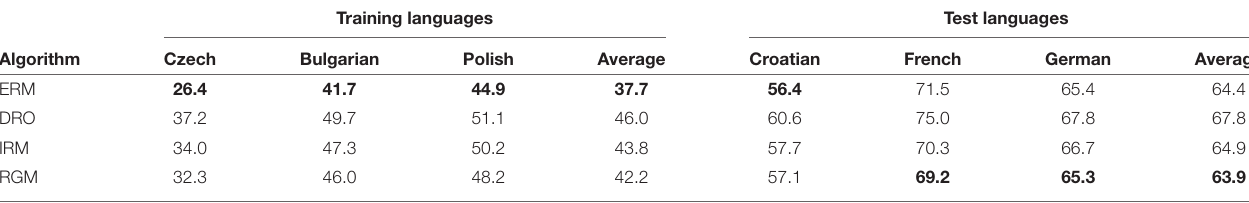
TABLE 3 | Phone token error rates (PTER, %) of an ASR trained on three Slavic languages (Czech, Bulgarian and Polish). Training languages Test languages